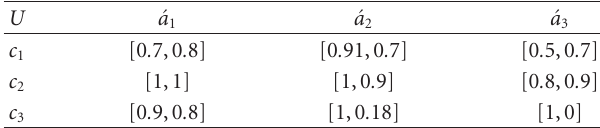
Table 2: Representation of truth-membership function of ( (cid:2) G , B ).